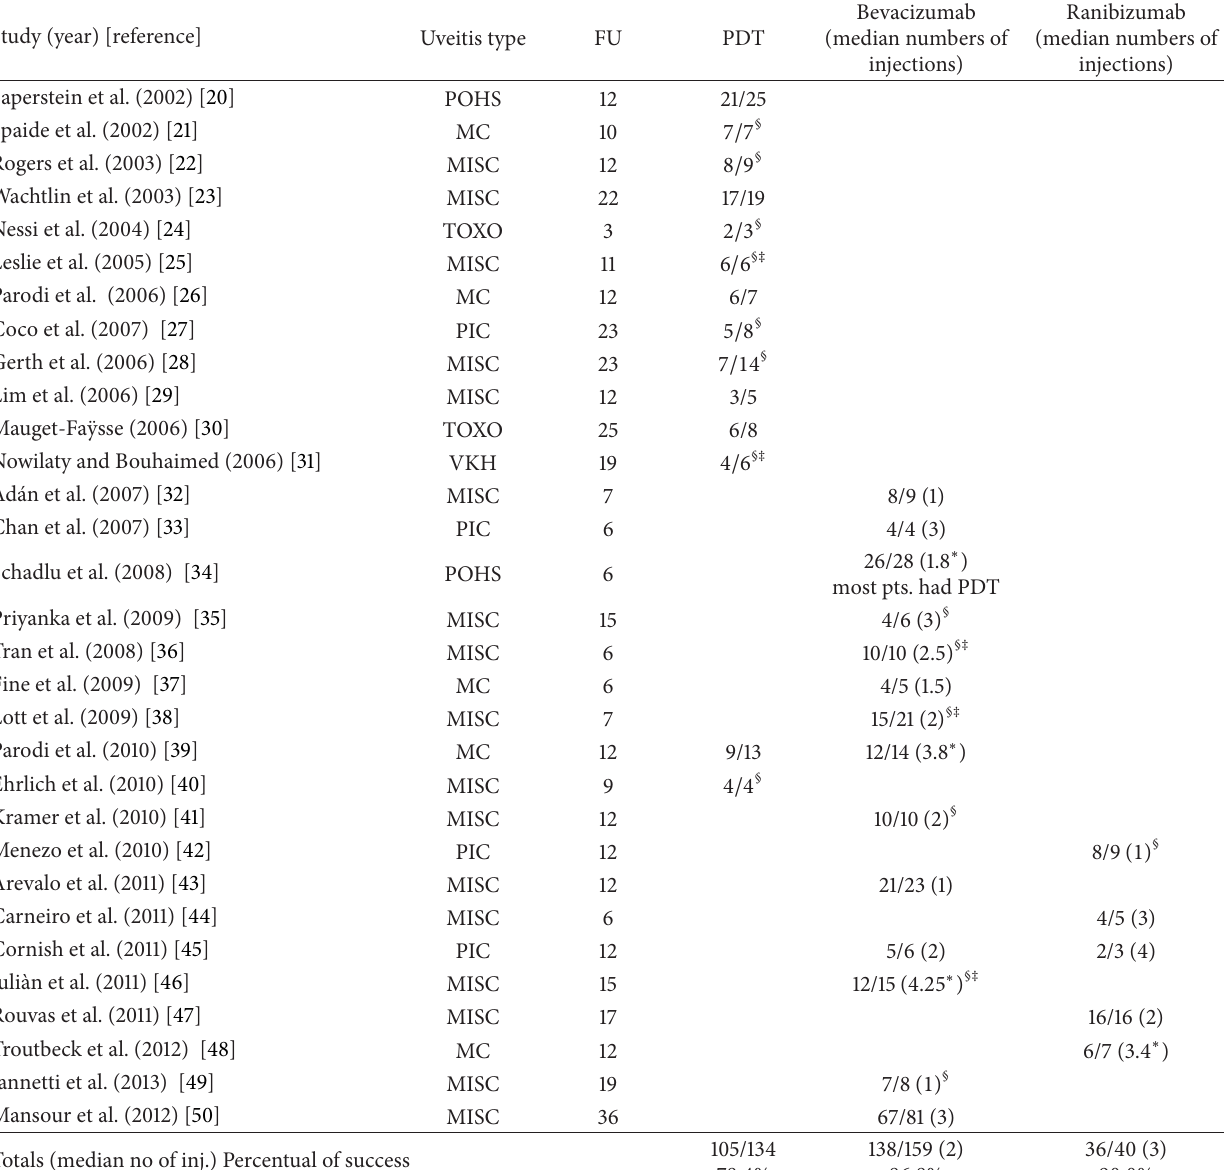
Table 2: Overview of the studies on the therapy of inflammatory